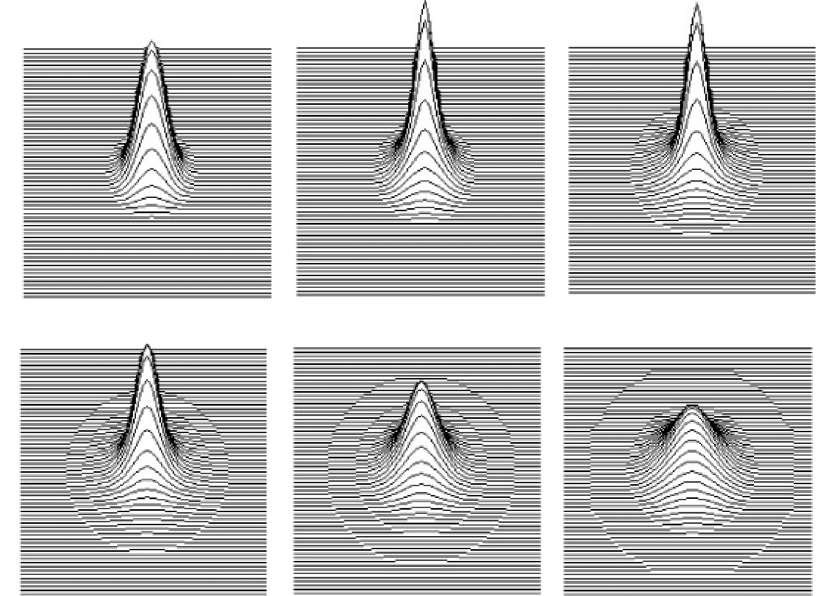
Figure 6.2 . Evolution of a Gaussian pulse on distance π with initial amplitude √ constant A 0 = 2 (the same as for the vortex solution) governed by the scalar NSE (6.3). The nonlinear parameter γ > 1 is greater than but close to the critical value for